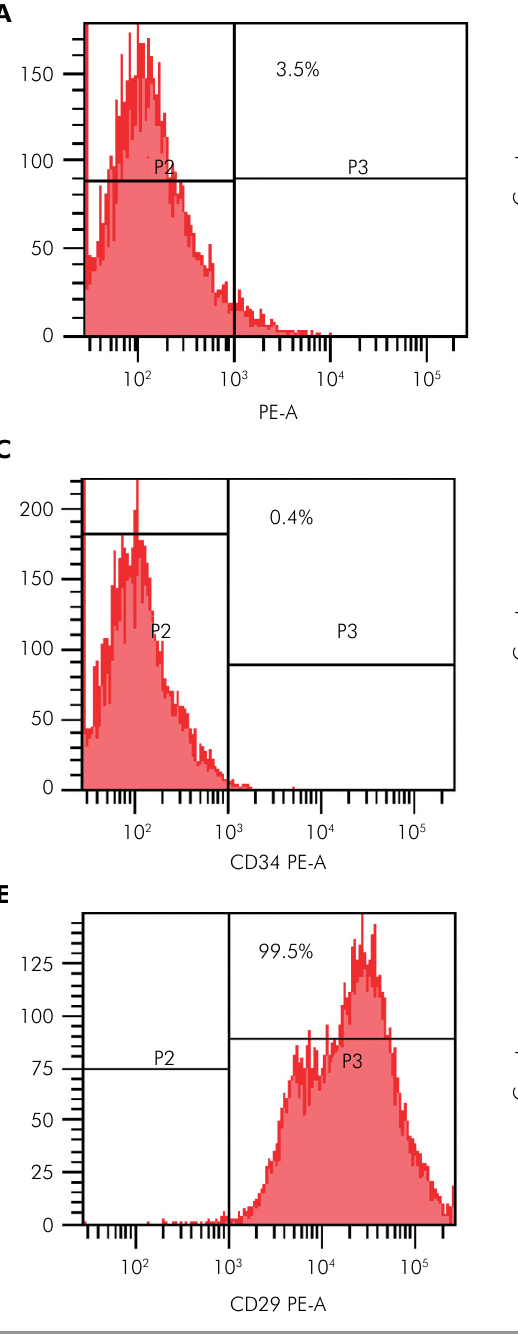
Figure 2. Identification of surface markers of MSCs by flow cytometry. The fluorescence background of nonlabeled cells (A) was subtracted from each percentage of labeled cells. Percentage of expression of CD31 (B), CD34 (C), CD106 (D), CD29 (E), and CD90